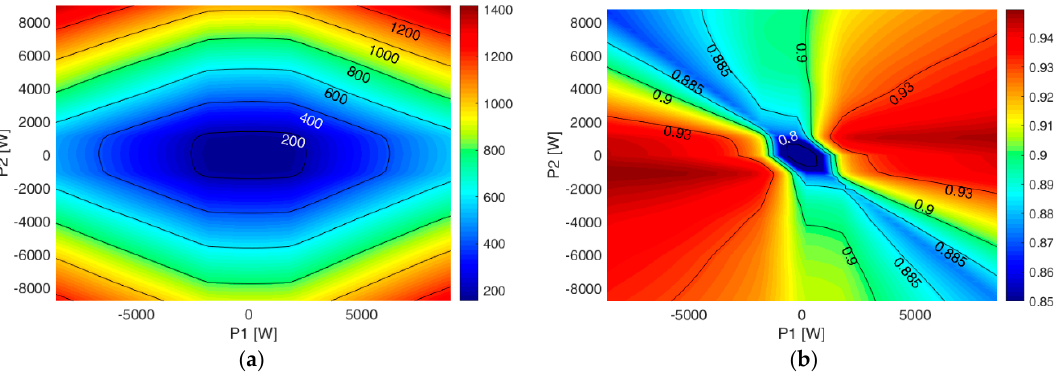
Figure 7. 4SC ( a ) Losses [W] ( b ) Efficiency.